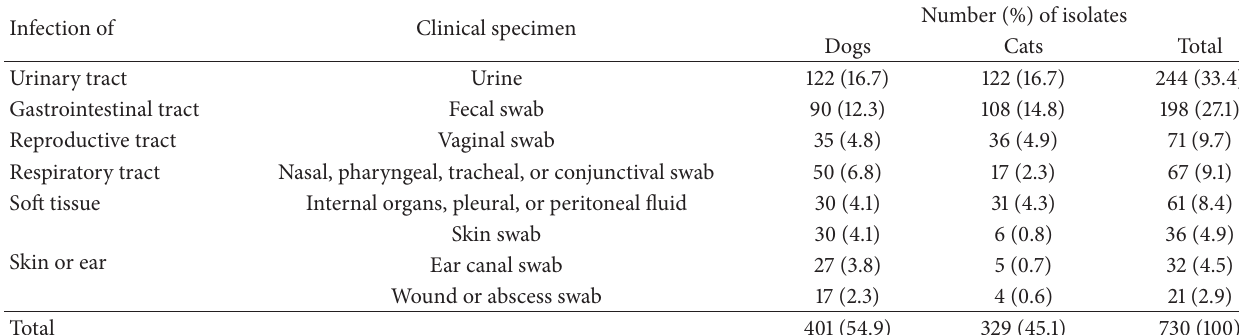
Table 1: Origin of E. coli isolates from diseased